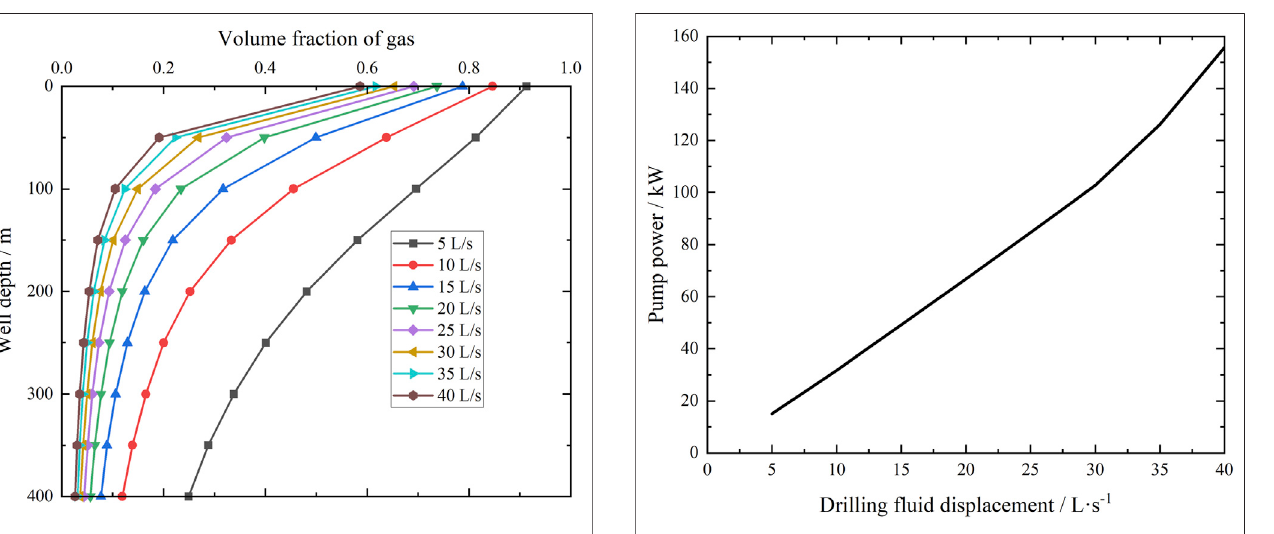
FIGURE 7 | Effect of drilling fl uid displacement on pump lifting